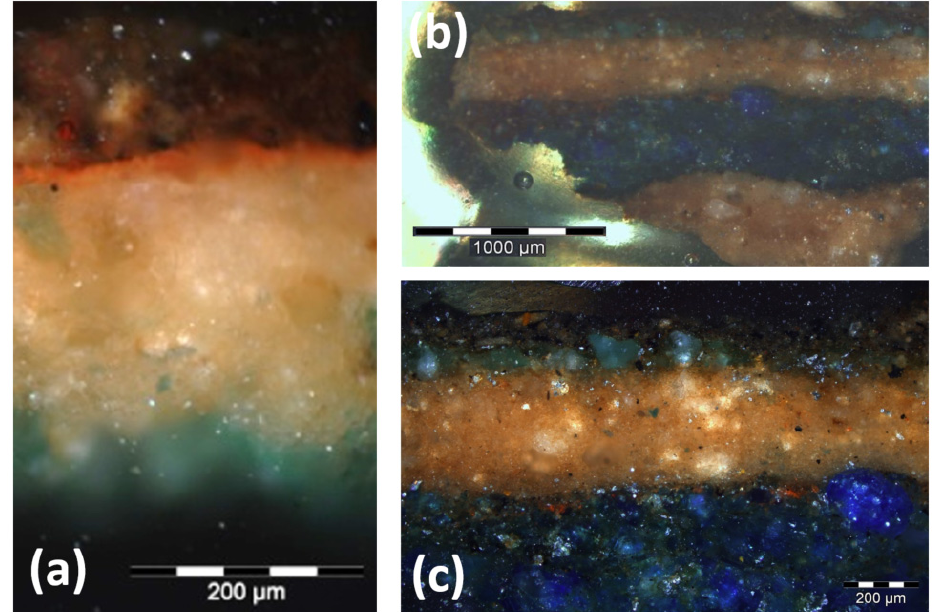
Figure 5. Optical Microscopy images (OM) of the two samples taken from the wig ( a ), sample A, and the body ( b , c ), sample B, of the sculpture; ( c ) is a magnification of a portion of sample B.